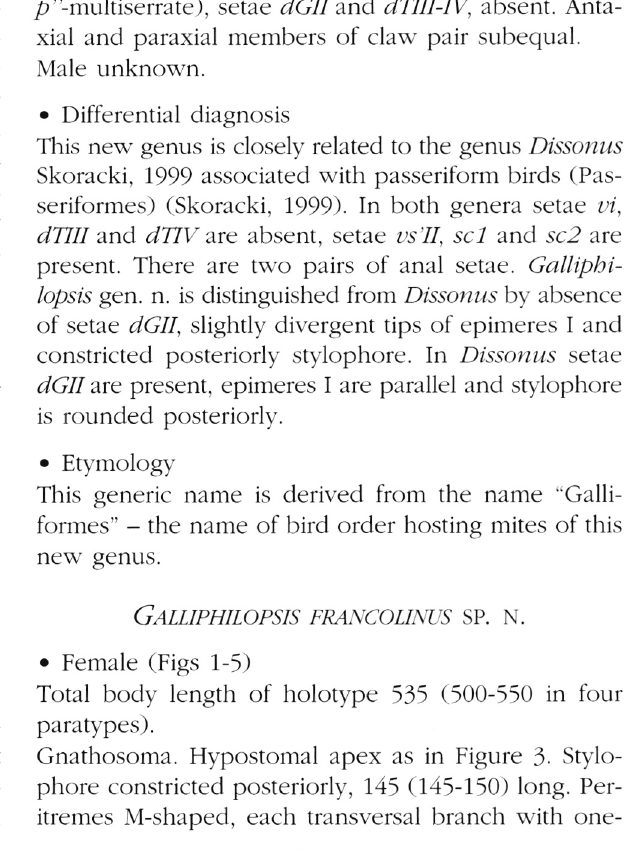
plate weakly sclerotized. Setal pattern of propodosomal region with five pairs of propodosomal setae present: ve, sci, h, sce and d 1 (vi - absent), arranged 1-1-1-2 (Fig. 1). Hysterosomal plate variable, weakly sclerotized or absent. Genital and anal series with two pairs of setae, respectively. Paragenital series with three pairs of setae. Epimeres I slightly divergent anteriorly, not fused to epimeres II. Leg setae smooth (except p'